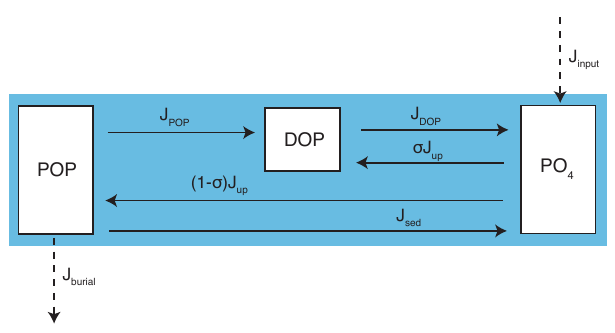
Figure 3. Schematic illustrating the transformations between the various phosphorus pools in the model: particulate organic phos- phorus (POP), dissolved organic phosphorus (DOP) and inorganic phosphate (PO 4 ). The J POP term is parameterized according to PRiSM as described in Sects. 2 and